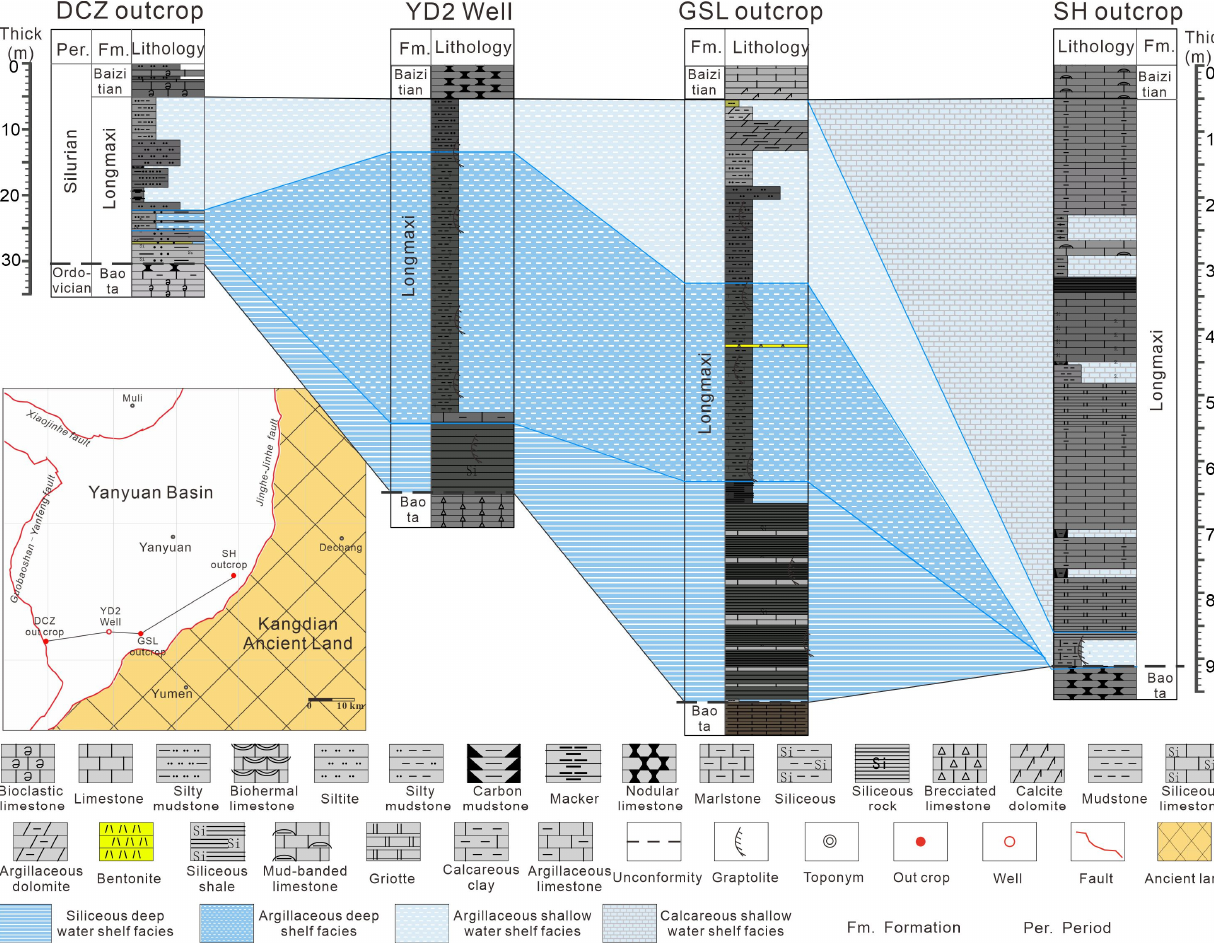
Figure 2. Stratigraphic correlation map of Longmaxi Formation in Yanyuan Basin.